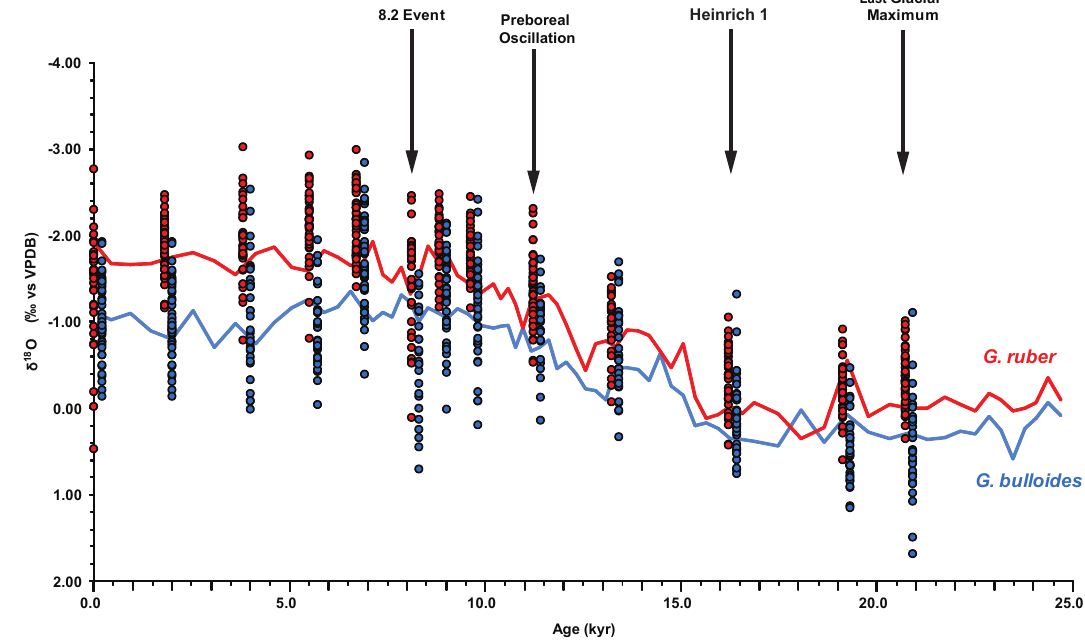
Fig. 3. Oxygen isotopes of G. ruber (red circles) and G. bulloides (blue circles) using individual specimen analysis against conventional isotope analysis (lines) from Ivanova (2000). Labels indicate key events outlined in text; note that G. bulloides single specimen data is offset by 0.2kyr from G. ruber data in order to aid visibility. The dataset represents uncorrected values.